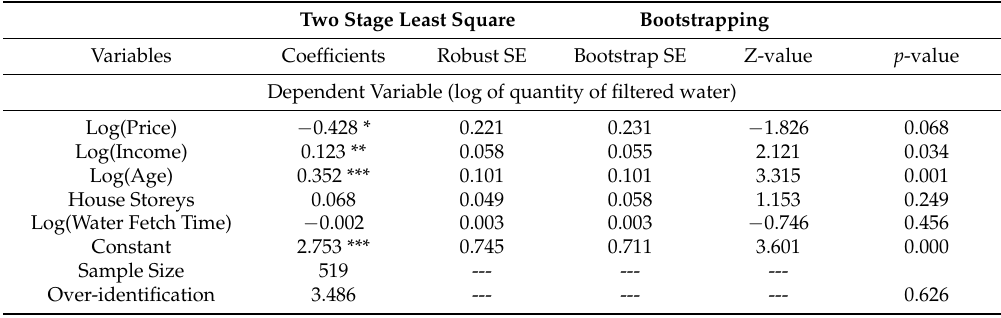
Table 4. Two-stage least square estimation of residential water demand (filtered